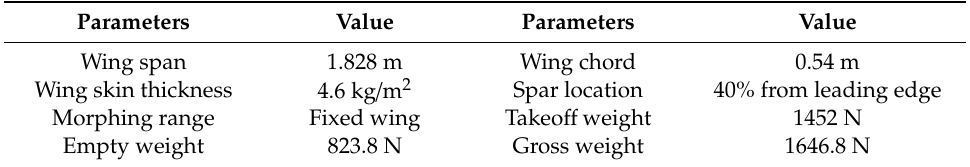
Figure 2. Computational model of camber morphing wing: actuators 1 – 6 show the position of the morphable ribs and the fixed spar location.